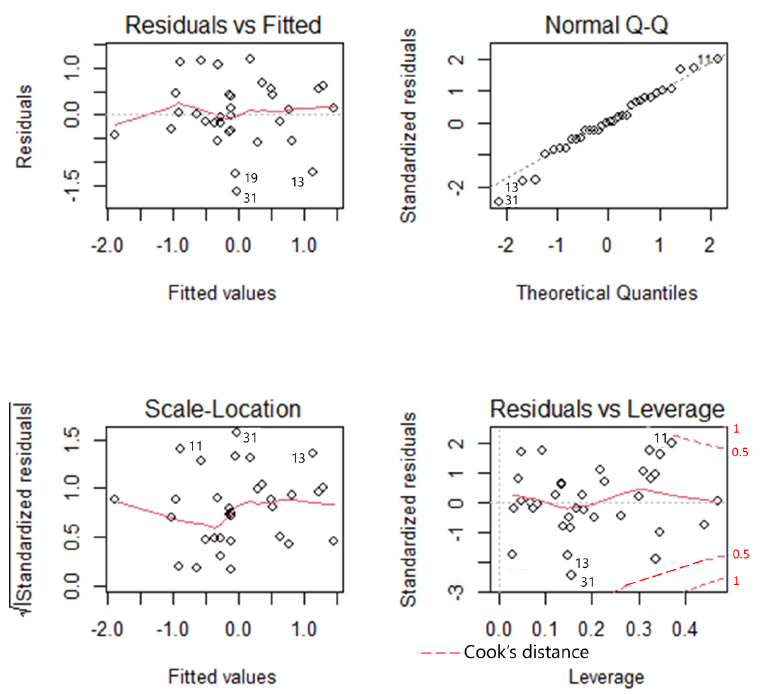
Figure A9. Model diagnostics for the best model with overall spring AA as the explained variable, and 15 climate variables and the Year as explanatory variables for the Pied Flycatcher Ficedula hypoleuca (Table